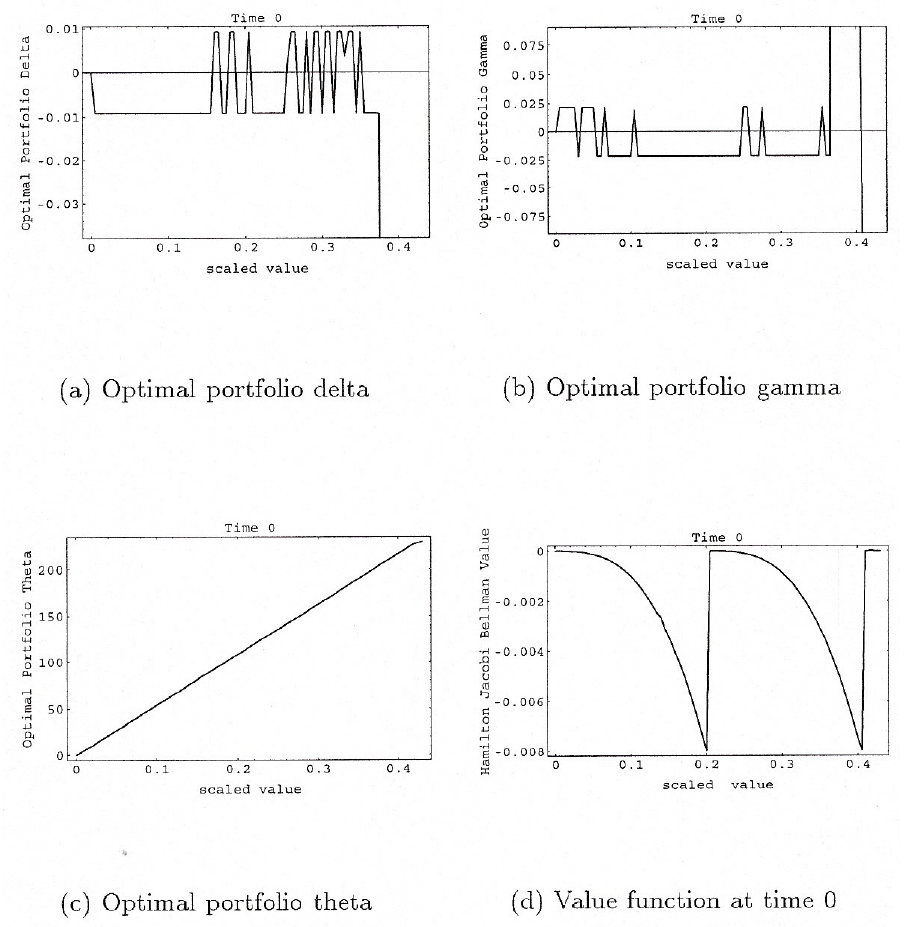
Figure 5. Optimal Portfolio sensitivities and value function at time